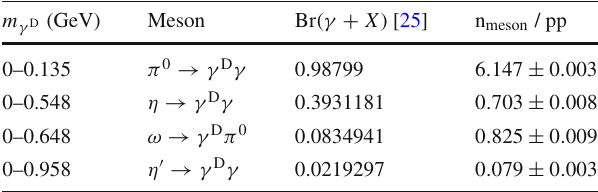
Table 1 Meson decay channels considered for the γ D production. The last column shows the average number of mesons expected per proton– proton interaction m γ D